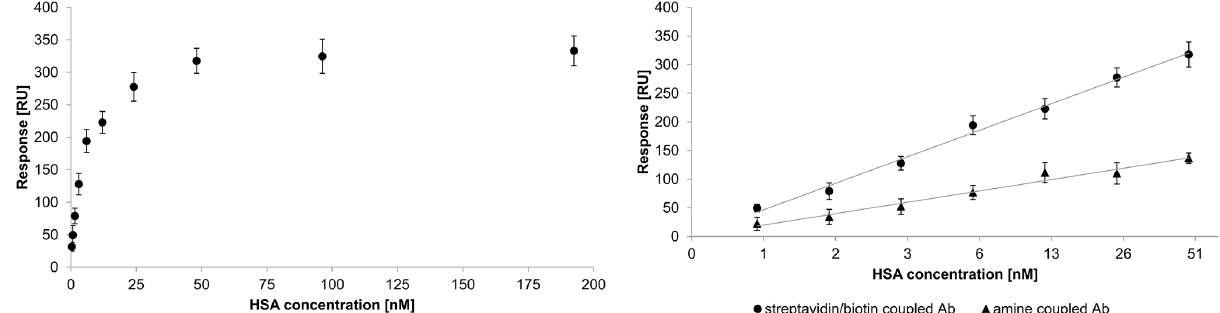
Figure 2. li SPR system binding responses obtained from sequentially injections of HSA (from bottom to top: 0.4, 0.8, 1.5, 3 , 6, 12, 24, 48, 96 and 192.5nM; left panel) and the resulting calibration curve, with a correlation coefficient of 0.9929, obtained from trails with HSA concentrations ranging from 0.8 to 48nM (right panel). Signals arising from reference antibodies were subtracted from those arising from the HSA-specific antibodies. Error bars indicate the deviations of means from four replicates.